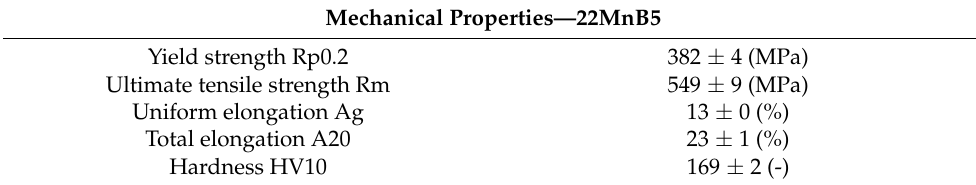
Table 2. Mechanical properties of 22MnB5.